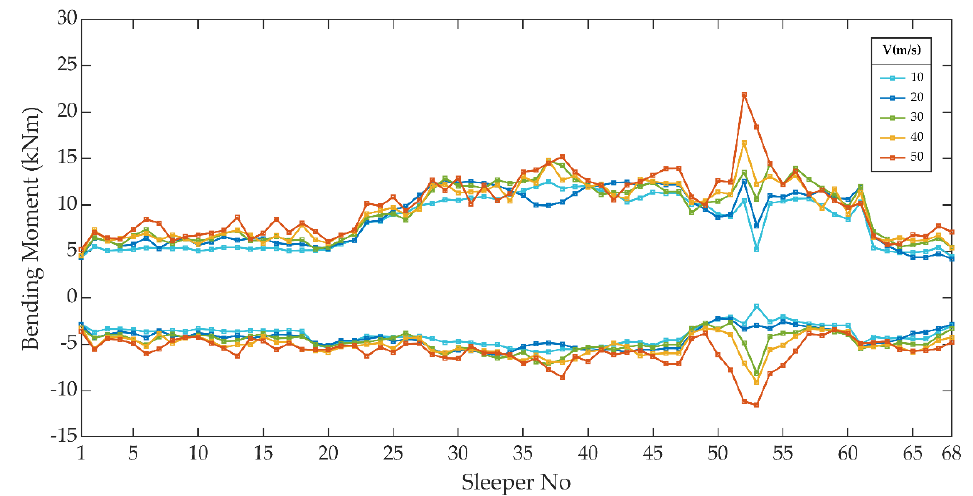
Figure 31. Maximum bending moments of the concrete bearers when one bearer under the crossing nose is